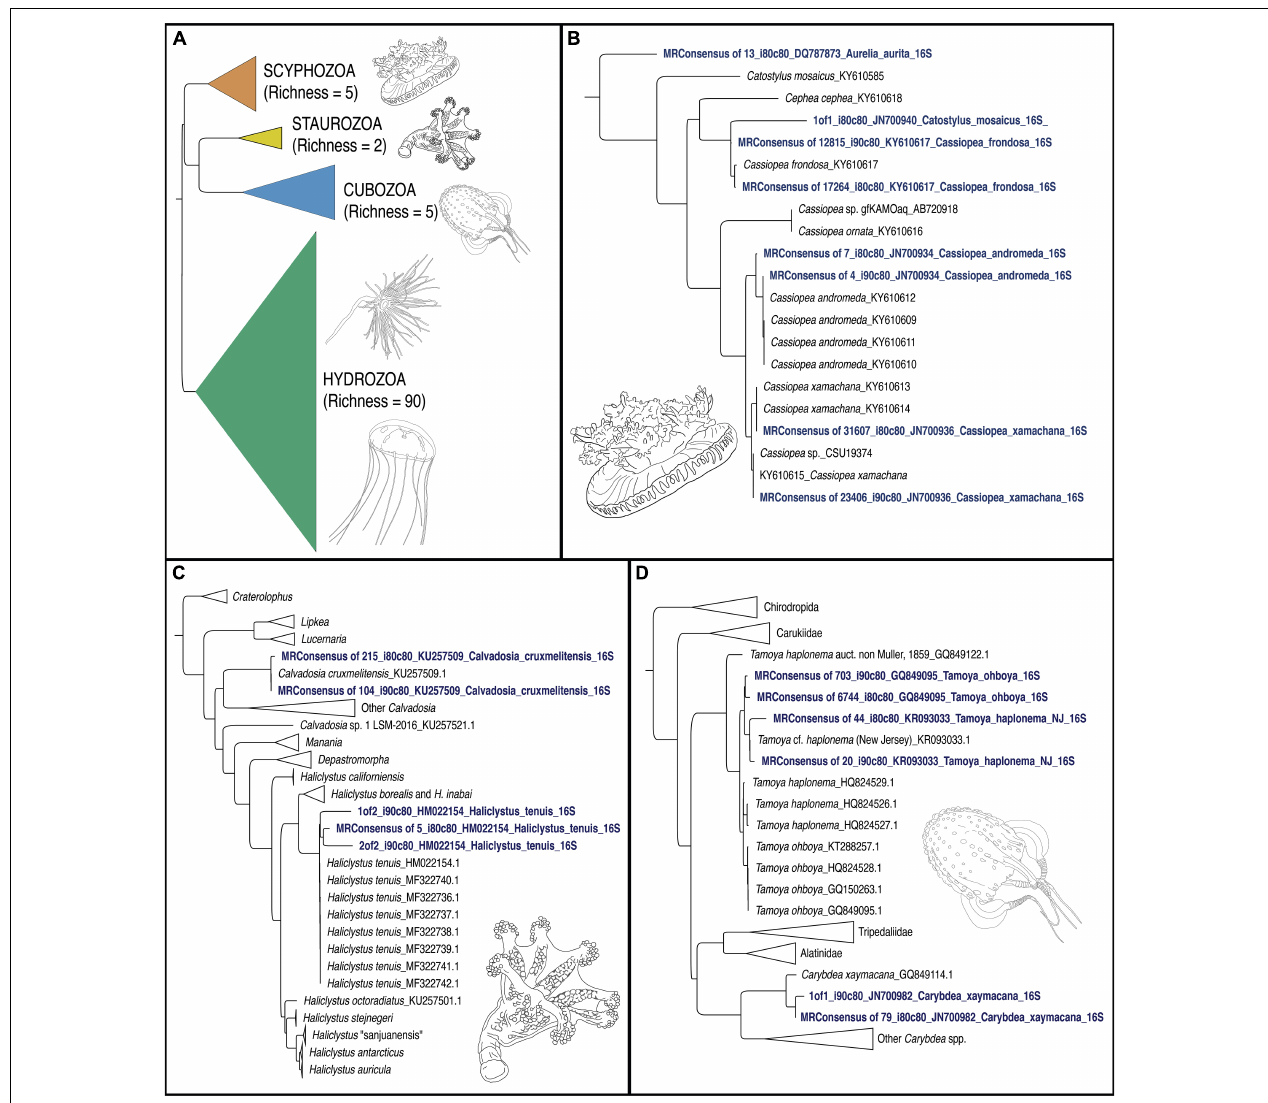
FIGURE 5 | Phylogenetic trees of jellyfish (Medusozoa) based on mitochondrial 16S rRNA gene eDNA profiling from the Florida Keys. (A) Phylogenetic reconstruction of representatives of all four medusozoan classes detected in eDNA samples. Terminal taxa consist of majority-rule consensus sequences of aligned sequence reads that showed BLAST similarity to target sequences at two thresholds (1) Percent identity > 90% and percent coverage > 80%, and (2) Percent identity > 80% and percent coverage > 80%) in cases where there were three or more such reads (see Figure 4 ). In cases where there were less than three such reads, these reads were included as terminals (GenBank accession numbers in Table 2 ). Richness refers to the number of OTUs for each class. Colors correspond to classes represented in mapped pie charts in Figure 6 . Phylogenetic reconstruction of 16S rRNA gene sequences in GenBank (NCBI) in tandem with relevant taxa detected as metabarcodes (denoted in blue letters). (B) Scyphozoa. Note that one read identified as > 80% identical to Catostylus mosaicus (an Indo-Pacific species) appears more likely to represent an aberrant read of C. frondosa . (C) Staurozoa. Representing the first record of Staurozoa in the Florida Keys. (D) Cubozoa. Note that two sets of reads showing high identity to Tamoya cf. haplonema from New Jersey (KR093033) and T. ohboya (GQ849095), respectively, both group with Tamoya cf. haplonema from New Jersey (KR093033) suggesting that the two sets of sequences may be associated with a single species rather than two. Hydrozoa phylogenetic tree not provided. Sequence alignments conducted with MAFFT (E-INSI algorithm), and tree reconstructed with FASTTREE on Geneious Prime version